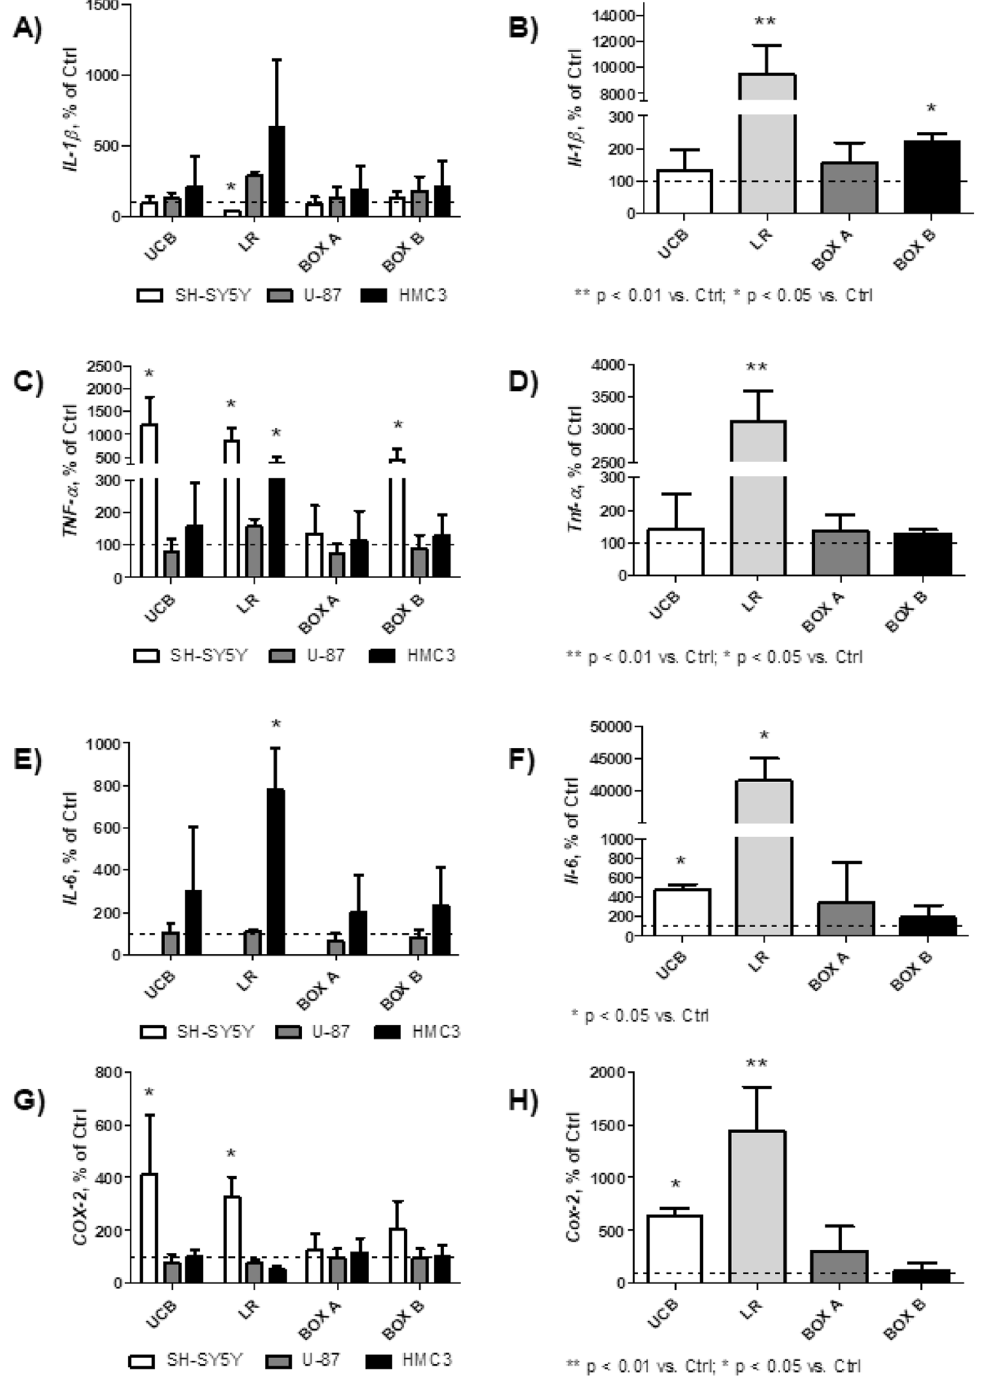
Figure 4. mRNA expressions of pro-inflammatory genes in CNS cells ( A , C , E , G ) and organotypic rat hippocampal slices ( B , D , F , H ). Four h exposure to UCB, LR, BOX A, or BOX B (25 μ mol/L). Controls expressed as 100%. SH-SY5Y, human neuroblastoma cell line; U-87, human glioblastoma cells; HMC3, human